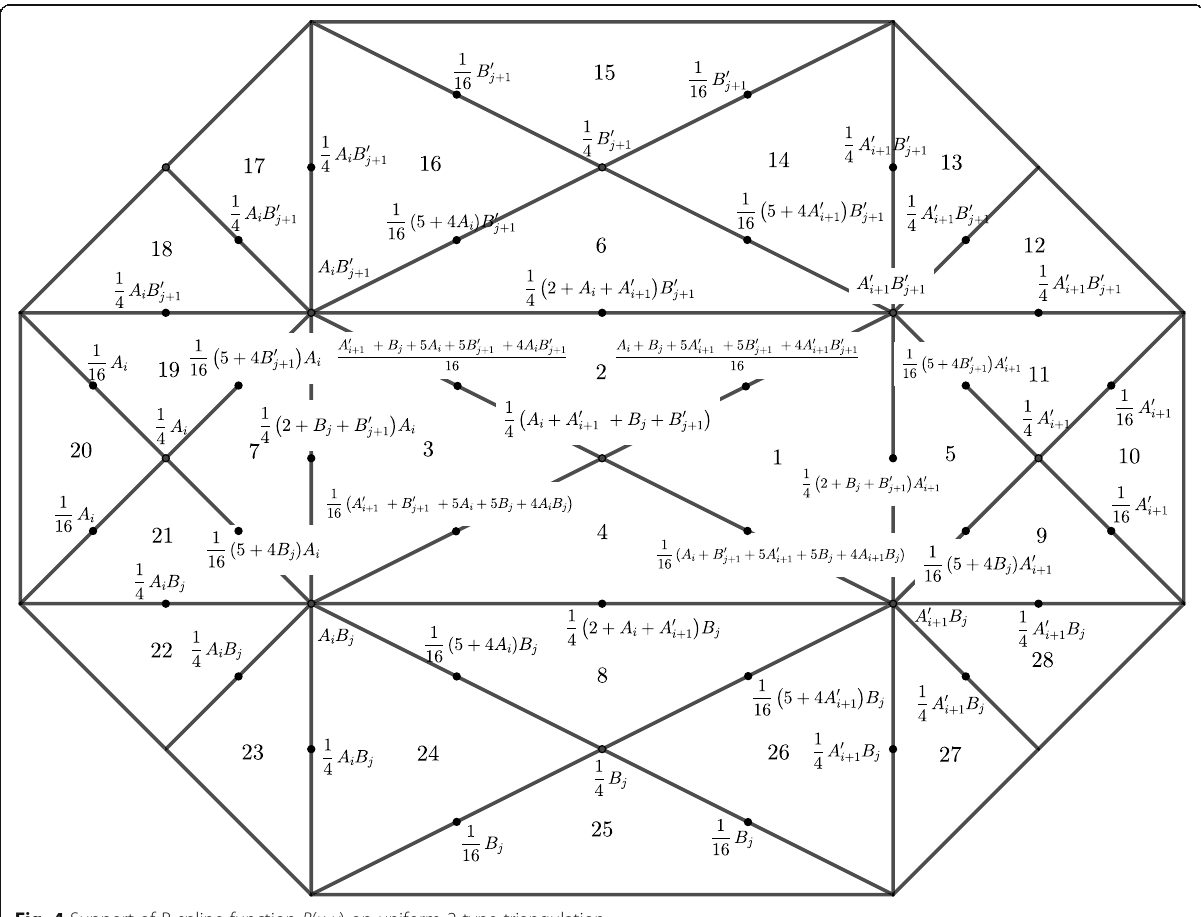
Fig. 4 Support of B-spline function B ( x , y ) on uniform 2-type triangulation